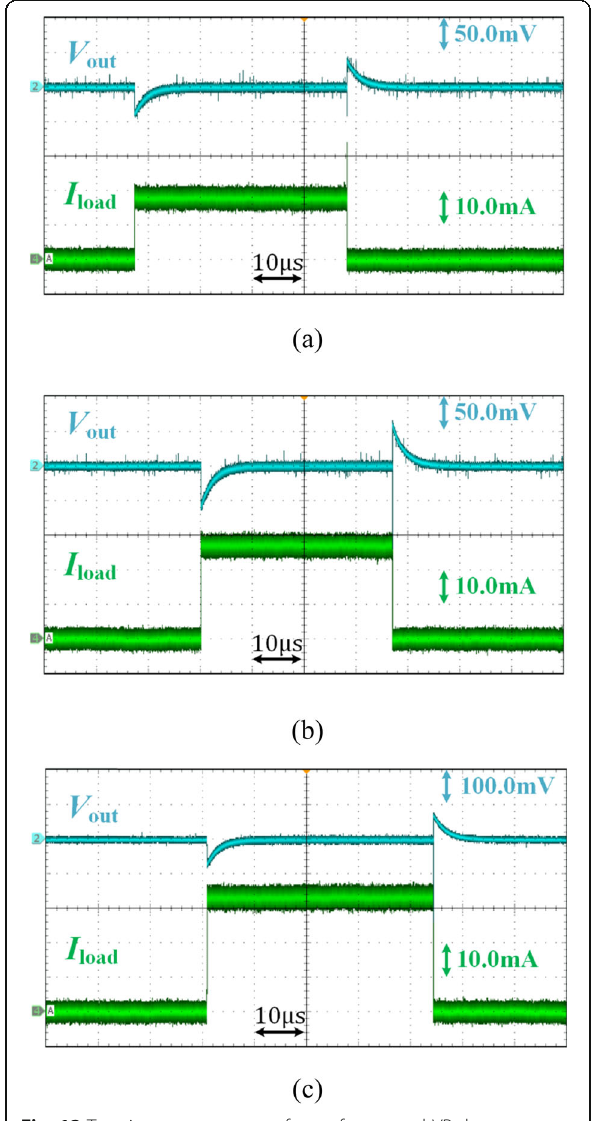
Fig. 13 Transient response waveform of proposed VR due to different load current step. a 0 to 18 mA; b 0 to 28 mA; c 0 to 32